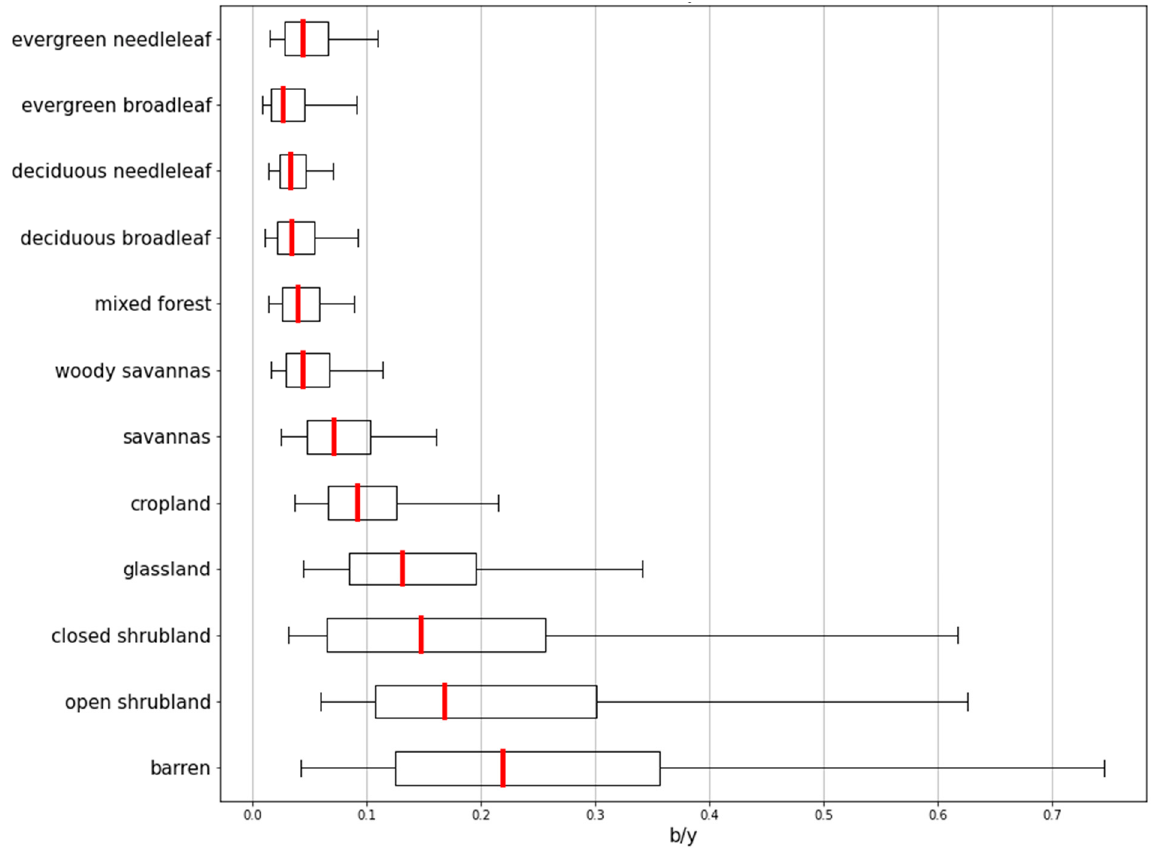
Figure 3. Boxplots of yearly b/y [-] (see Section 2) stratified by land cover types. Pixels of water, wetland, urban, mosaic, and ice are excluded.